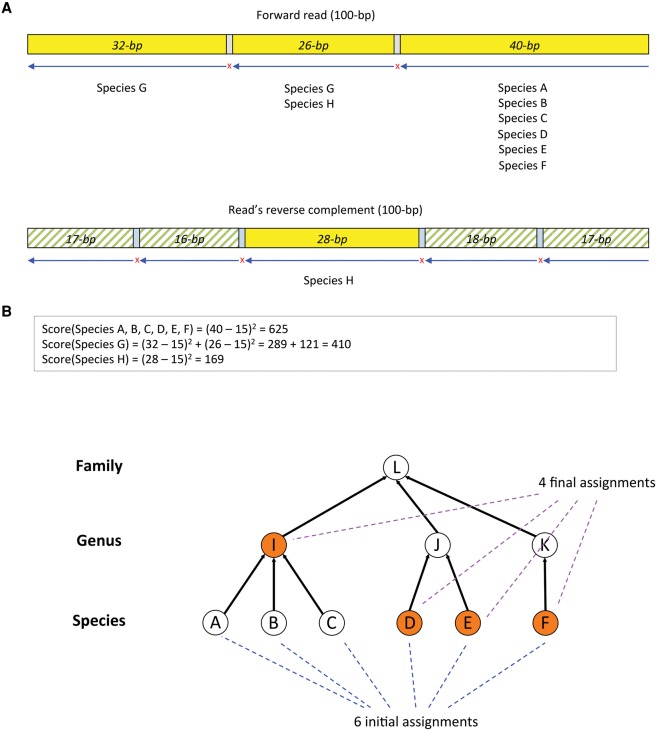
Classification of reads. (A) The figure shows how the score for a candidate at the species level is calculated. Given a 100-bp read, both the read (forward) and its reverse complement from right to left are searched. Centrifuge first identifies a short exact match, then continues until reaching a mismatch: The first 40-bp segment exactly matches six species (A, B, C, D, E, F), followed by a mismatch at the 41st base; the second 26-bp segment matches two species (G and H), followed by a mismatch at the 68th base; and the third 32-bp segment matches only species G. This procedure is repeated for the reverse complement of the read. Centrifuge assigns the highest score (625) to species A, B, C, D, E, and F. (B) Centrifuge then traverses up the taxonomic tree to reduce the number of assignments, first by considering the genus that includes the largest number of species, genus I, which covers species A, B, and C, and then replacing these three species with the genus. This procedure results in reducing the number of assignments to four (genus I plus species D, E, and F).